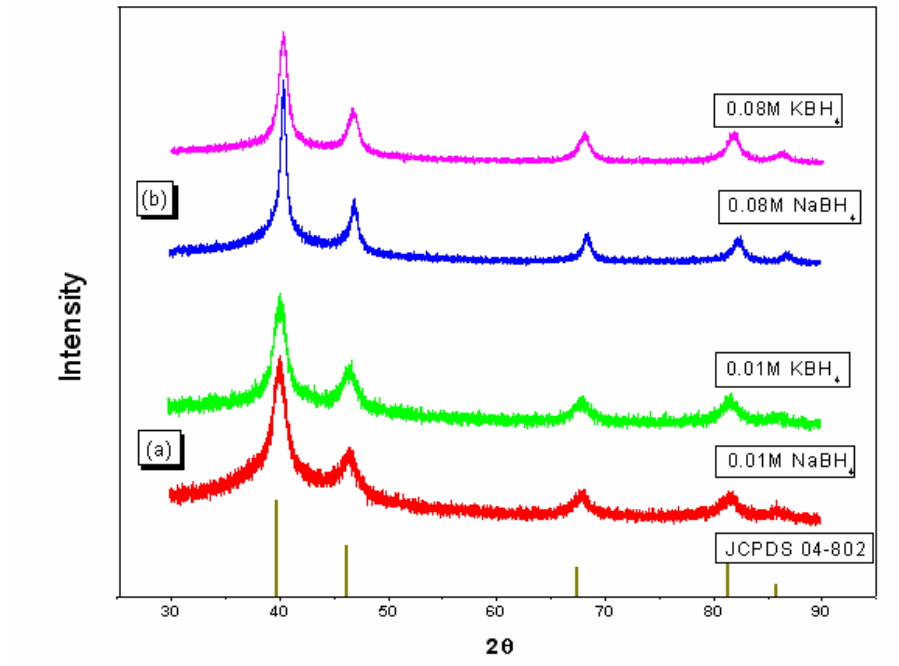
Figure 2. X-ray diffraction pattern of the Pt | Nafion ® electrode assembly prepared from 0.01 M ) Cl and different reductant concentrations (a) 0.01 M NaBH Pt(NH 3 4 2 and KBH . 4 Table 1. Average crystallite diameter (d) of the Pt grains deposited at the surface of the Nafion electrolyte prepared from Pt(NH